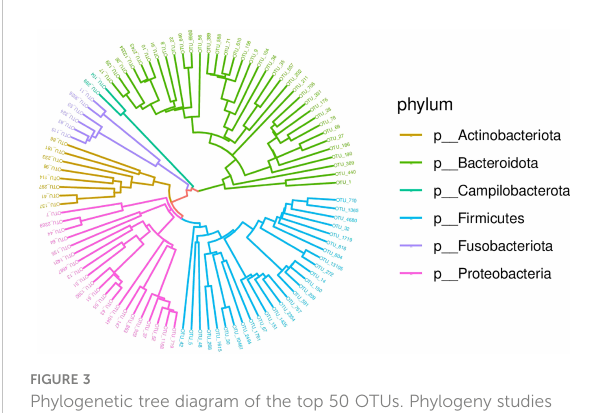
FIGURE 3 Phylogenetic tree diagram of the top 50 OTUs. Phylogeny studies the formation and evolution history of species. In this Circle Tree, the top 50 species with the highest abundance during evolution are clustered into six